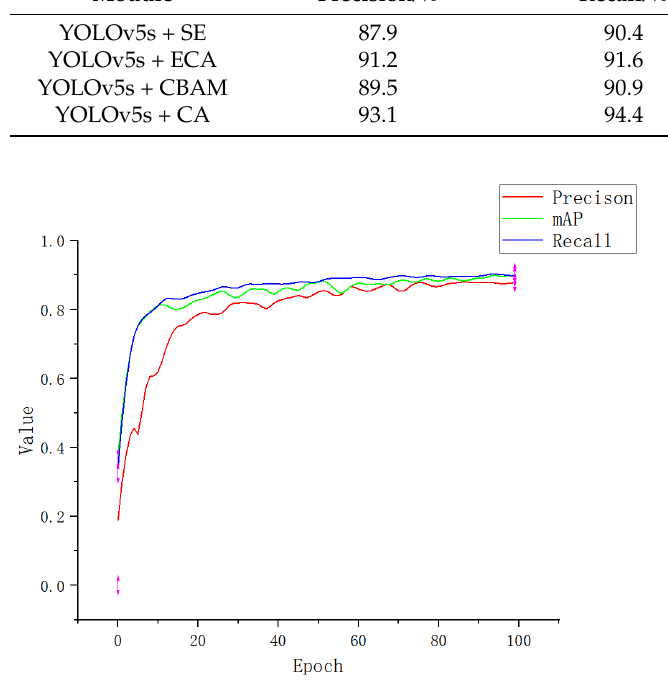
Figure 12. Performance index curve of SE.